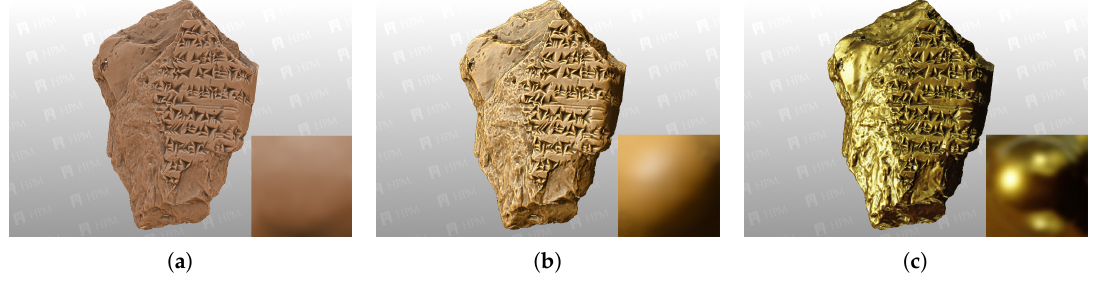
Figure 3. A set of different materials, with the corresponding square lit-sphere texture shown in the bottom right, including diffuse clay ( a ), glossy clay ( b ) and polished gold ( c